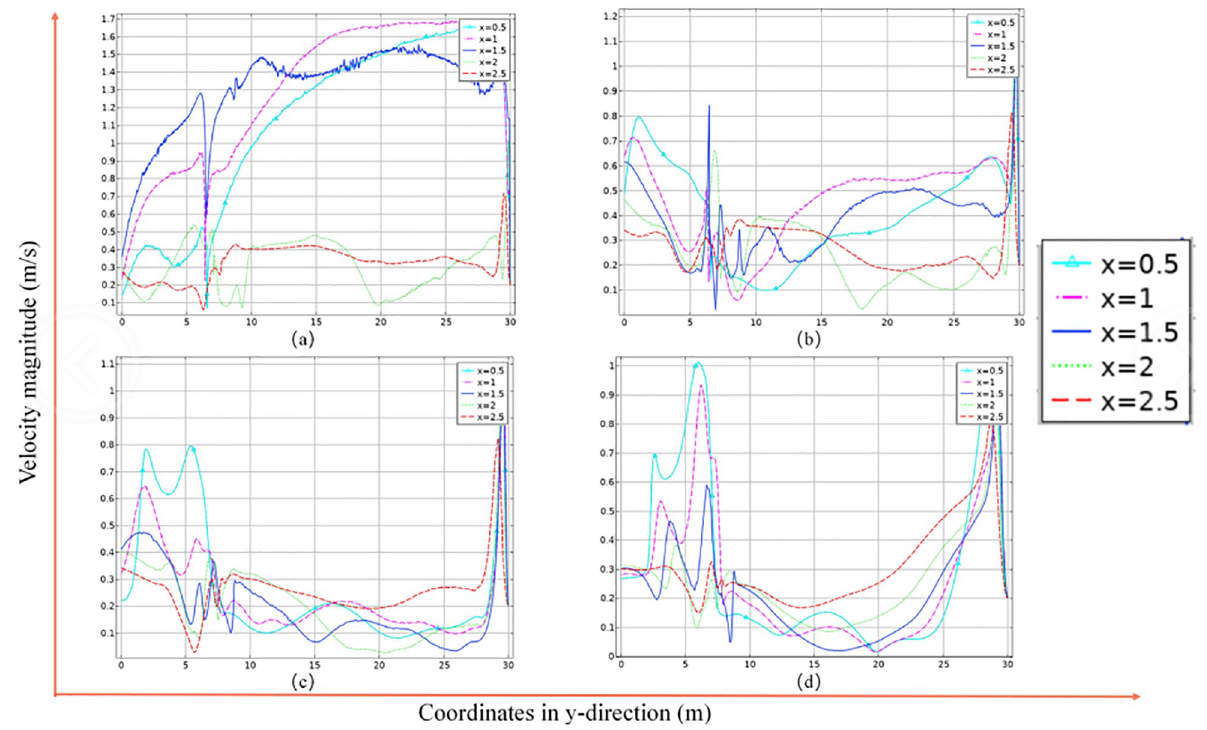
Fig 8. Wind flow distribution curve in the centre of the lower